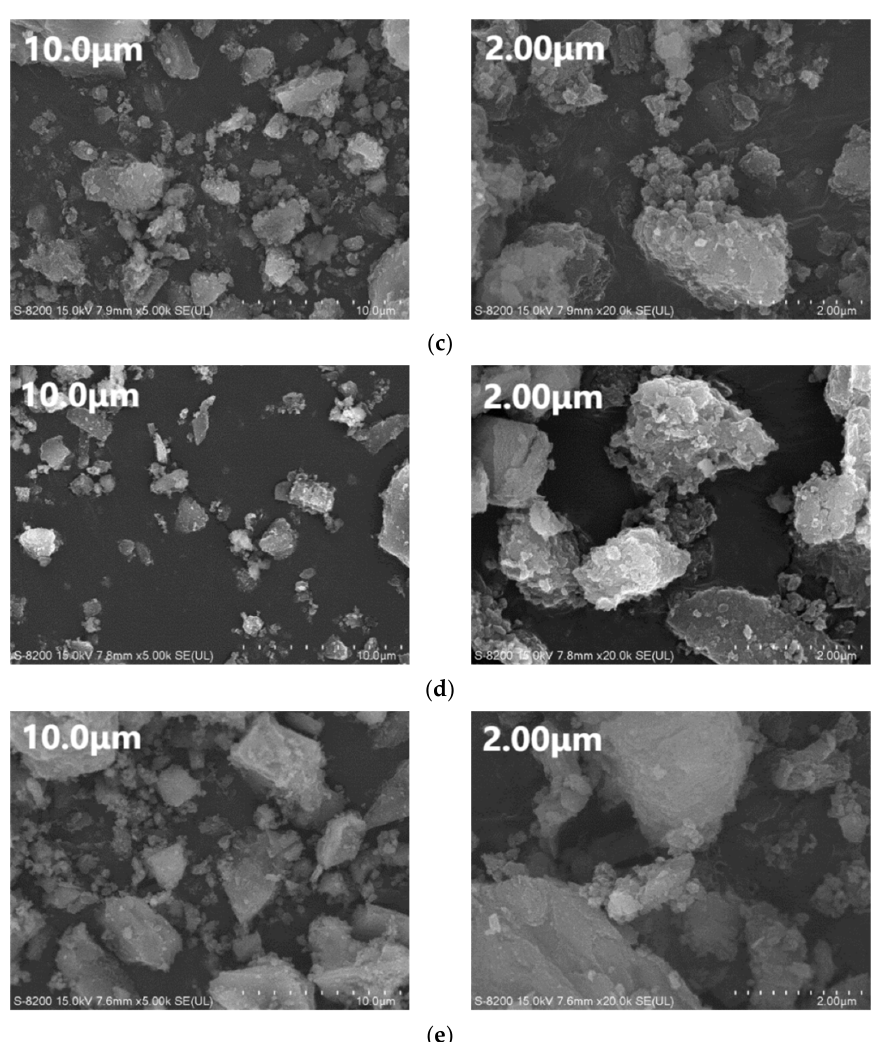
Figure 2. SEM characterization of Cu-doped MnO 2 catalysts. ( a ) MnO 2 /γ-Al 2 O 3 , ( b ) Cu 0.05 Mn/γ-Al 2 O 3 , ( c ) Cu 0.15 Mn/γ-Al 2 O 3 , ( d ) Cu 0.25 Mn/γ-Al 2 O 3 , ( e ) Cu 0.5 Mn/γ-Al 2 O 3 .